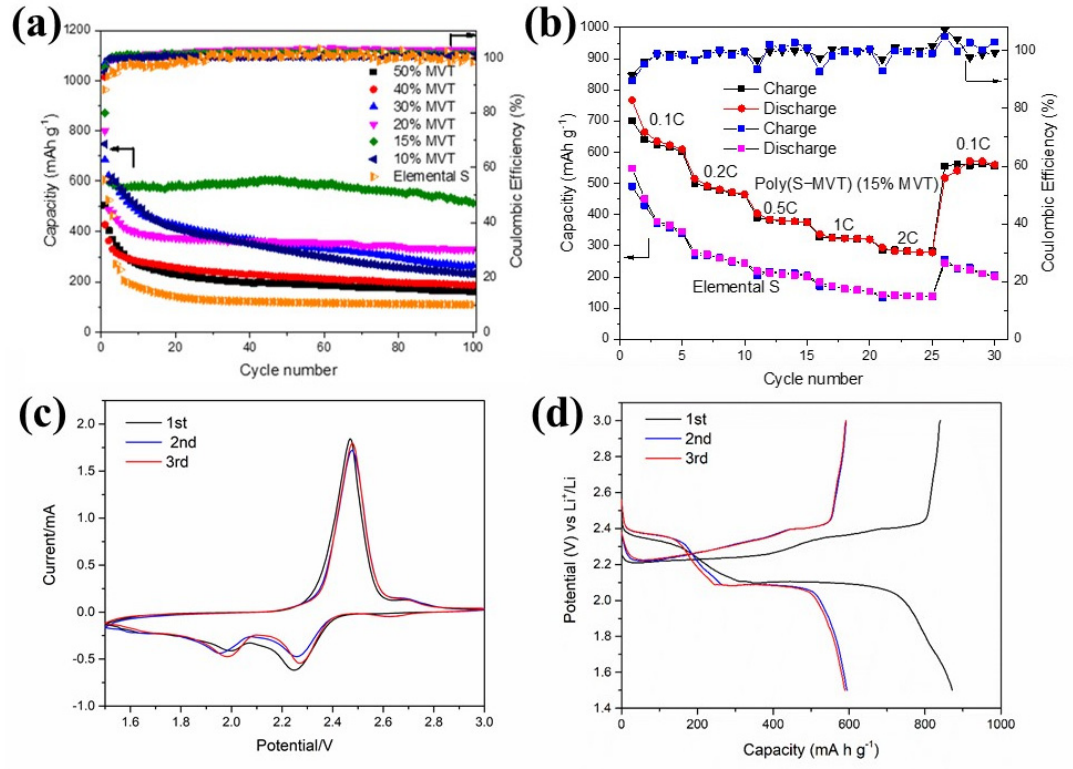
Figure 6. ( a ) Galvanostatic charge–discharge cycling of different poly(S-MVT)s at 0.1 C (capacity calculated based on the mass of poly(S-MVT)) and elemental sulfur (S). ( b ) Rate capacity of the poly(S-MVT) (15% MVT) copolymer and elemental sulfur S based electrodes at varied rates. ( c ) Cyclic voltammograms of the poly(S-MVT) (15% MVT) copolymer cathode at a scan rate of 0.1 mVs − 1 . ( d ) Charge–discharge profiles of Li-S batteries with poly(S-MVT) (15% MVT) copolymer cathode at 0.1 C. It is worth noting that the initial coulombic efficiency of poly(S-MVT) (15% MVT) based Li-S cell is 96.57%, and after the second cycle, the coulombic efficiencies are